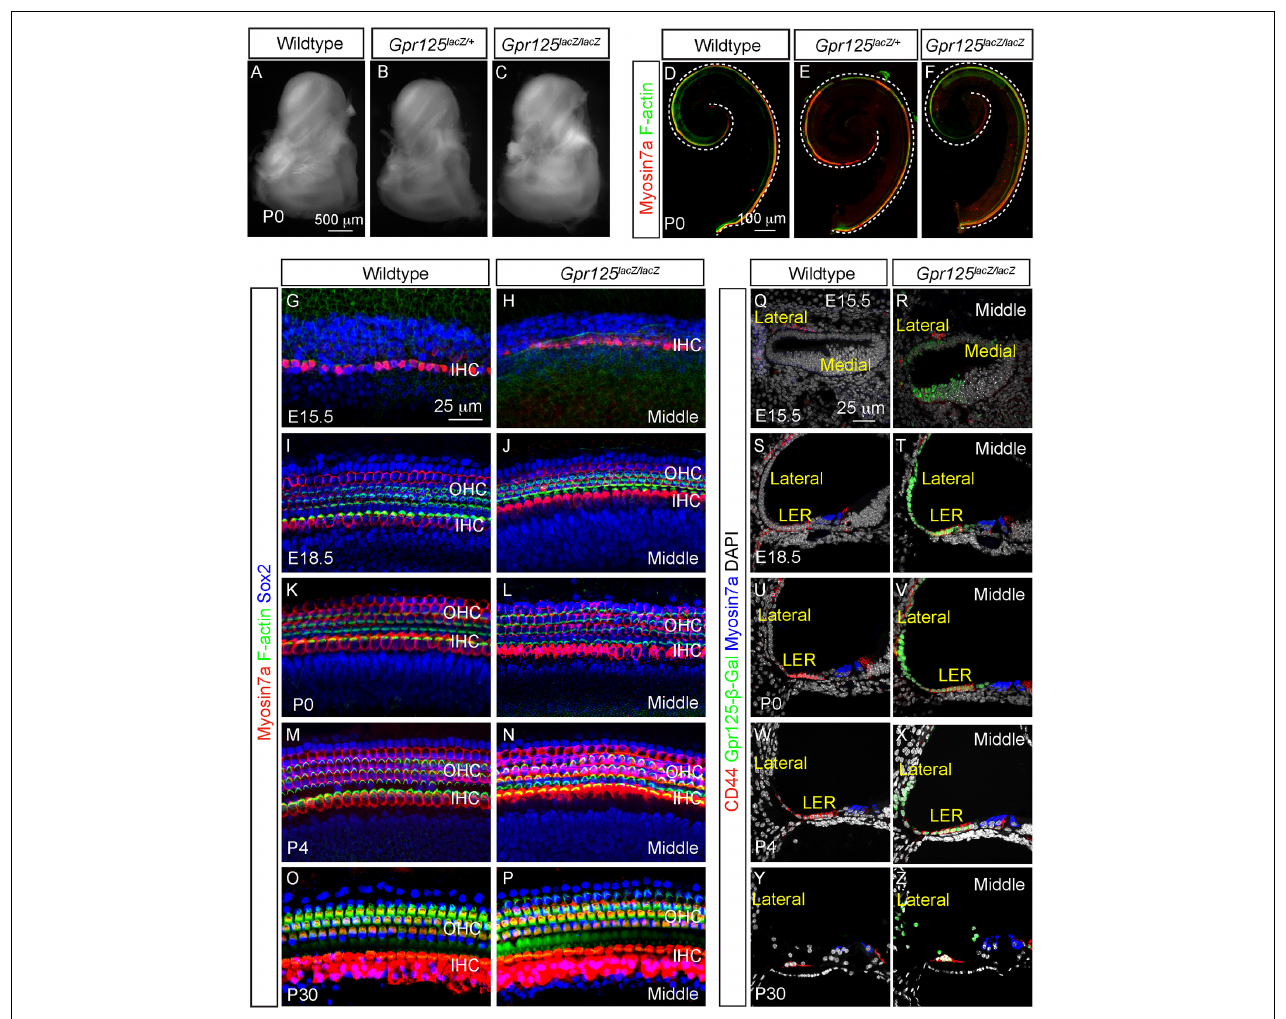
FIGURE 6 | Gpr125 is dispensable for cochlear development. (A–C) Otic capsule from P0 wild-type, Gpr125 lacZ / + , and Gpr125 lacZ / lacZ mice. (D–F) Whole mount preparation of cochleae from the wild-type, Gpr125 lacZ / + , and Gpr125 lacZ / lacZ mice showing no differences in length. (G–P) Whole mount preparation of E15.5, E18.5, P0, P4, and P30 cochleae immunostained for Myosin7a (red), F-actin (green), and Sox2 (blue), demonstrating no detectable loss of hair cells, hair bundles, or supporting cells in the Gpr125 lacZ / lacZ cochleae. Images were taken from the middle turn. (Q–Z) Representative sections through the middle turn of E15.5, E18.5, P0, P4, and P30 cochleae from wild-type and Gpr125 lacZ / lacZ mice. Gpr125 lacZ / lacZ mutants demonstrate relatively normal cochlear morphology, including in the stria vascularis and LER that strongly express Gpr125- β